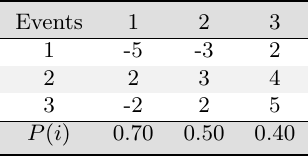
Table 1: The 3 × 3 causal cross-impact matrix, where the column events (driving events) affect the row events (driven events).